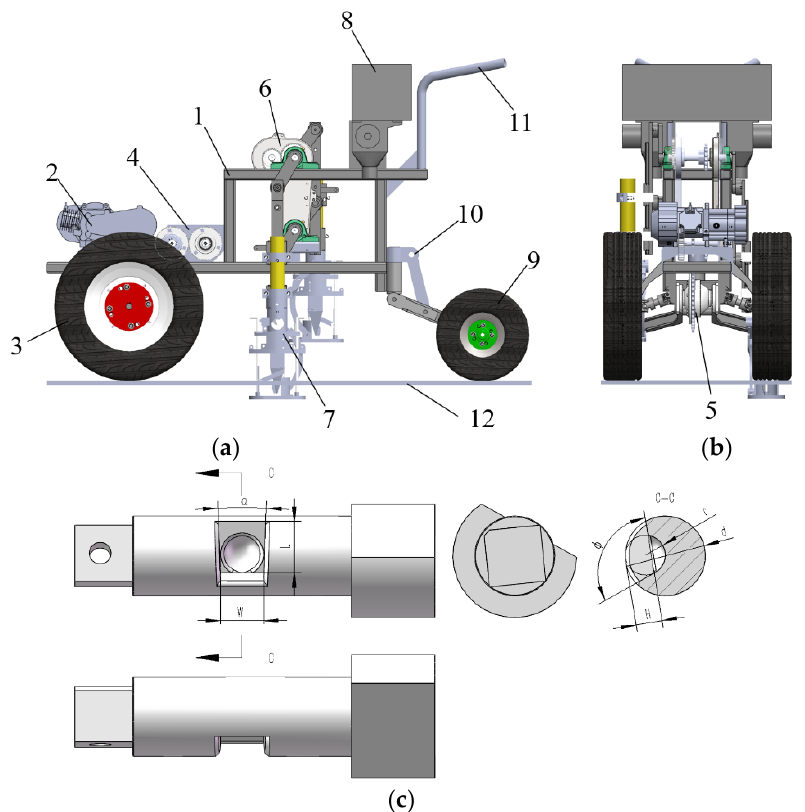
Figure 1. Structural components of the maize cavity planter with vertical insertion. ( a ) Main view. ( b ) Front view. ( c ) Structure schematic of shaped groove. (1) frame; (2) engine; (3) traction wheel; (4) gearbox; (5) differential; (6) forward speed compensation mechanism; (7) cavity seeder; (8) outer grooved wheel seed discharger; (9) guide wheel; (10) guide frame; (11) handle; (12) ground. Note, L is the length of shaped groove. W is its width. H is the height. α is opening angle of the groove. d is the diameter of seed taking wheel. r is the maximum diameter of the spherical hole. φ is the included angle of the inner groove line.